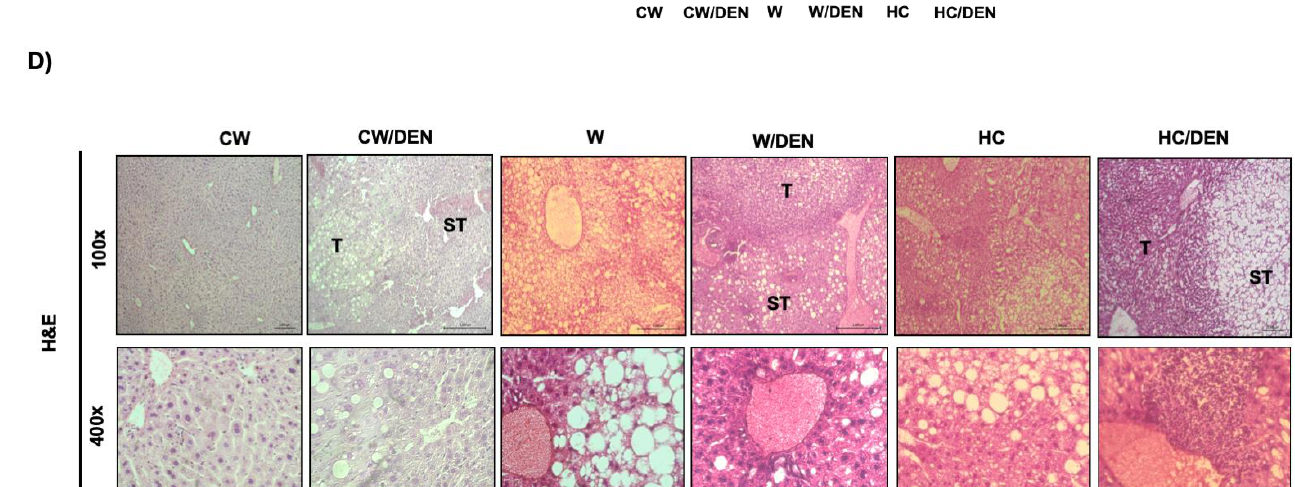
Figure 2. The consumption of a Western diet induces lipid liver overload and hepatic tumors. ( A ) Gross inspection of the livers from mice fed with the different diets and treated or not with DEN. Arrows and arrowheads show tumors. Repre- sentative images of at least eight animals per group. ( B ) Liver cholesterol and triglycerides content ( n = 4). ( C ) Number of tumors in livers from different groups of mice. Each graph plots the individual data points, the superimpose horizontal line indicates the arithmetic mean and error bars showing ± SEM ( n = 8). ( D ) mouse and ( E ) human liver tissue histology